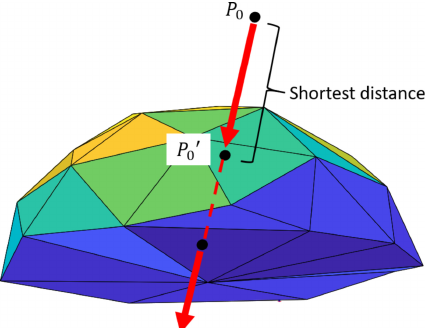
Figure 7. Infinite-line crosses a close body by at least two times.